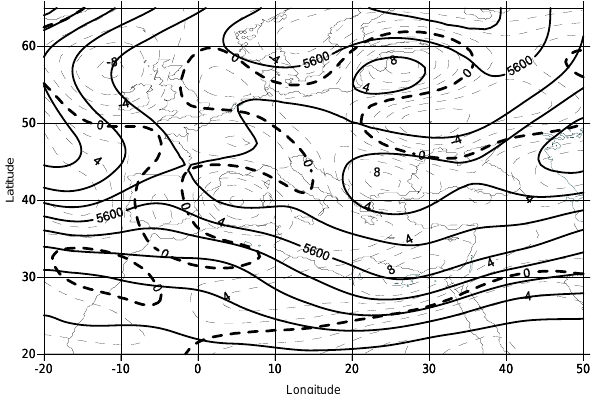
Fig. 4. Geopotential height (solid lines, gpm) over the 500hPa iso- baric surface and relative vorticity (dashed lines, × 10 − 5 s − 1 ) over the 300hPa isobaric surface for the cluster “North”, at time D0.